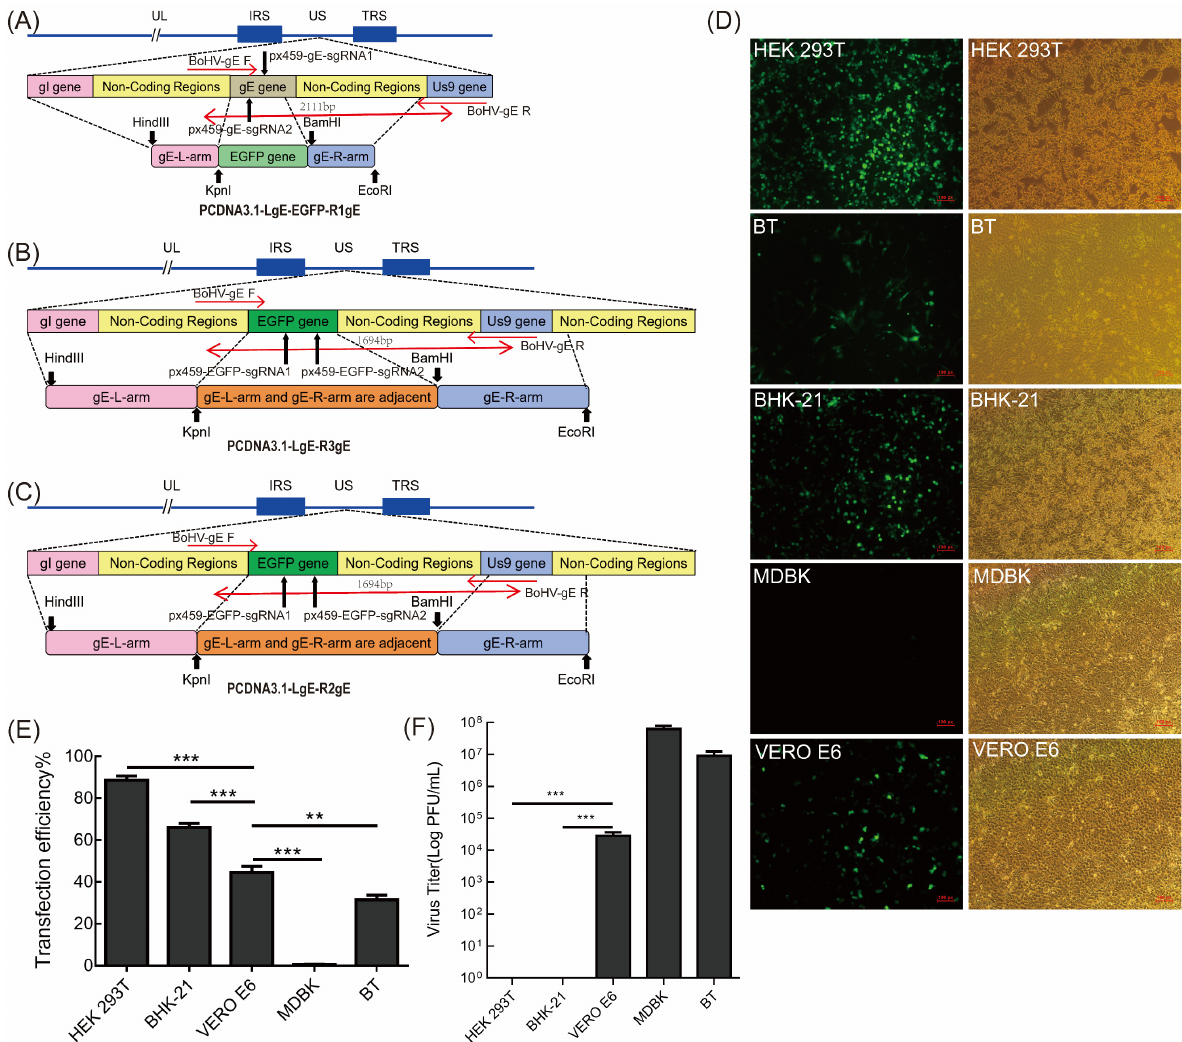
Figure 1. Construction of the BoHV-1 Δ gE donor plasmid and determination of the cell lines for transfection. ( A – C ) Schematic showing the donor plasmid sequence used to edit BoHV-1 and the re-combination sites inserted into the BoHV-1 genome. The long black arrows represent the sgRNA cleavage site, the short black arrows represent the restriction enzyme cutting site, and the short red arrows and long red arrows represent the primer position and product size, respectively. ( D ) The transfection efficiency of the empty px458 vector in different cell lines. Fluorescence was evaluated after 48 h. ( E ) Flow cytometry analysis of HEK293T, BHK-21, VERO E6, MDBK, and BT cell transfection efficiency. ( F ) BoHV-1 virus titer in different cells. The 80% confluent MDBK, BT, HEK293T, and VERO E6 cells were infected with 10-fold proportional serial dilutions of the virus. There were significant differences between the different cell lines. The data are shown as mean ± SD; ** p < 0.01, and *** p < 0.001.